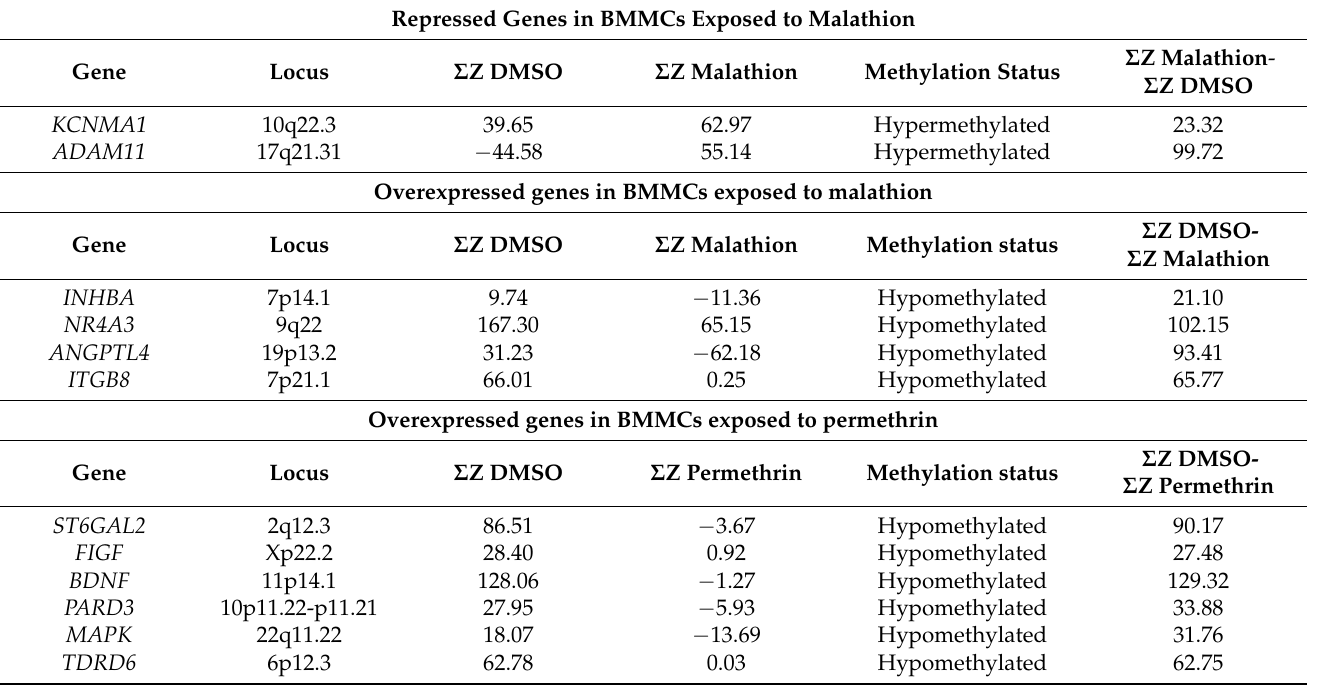
Table 6. Methylation analysis of selected